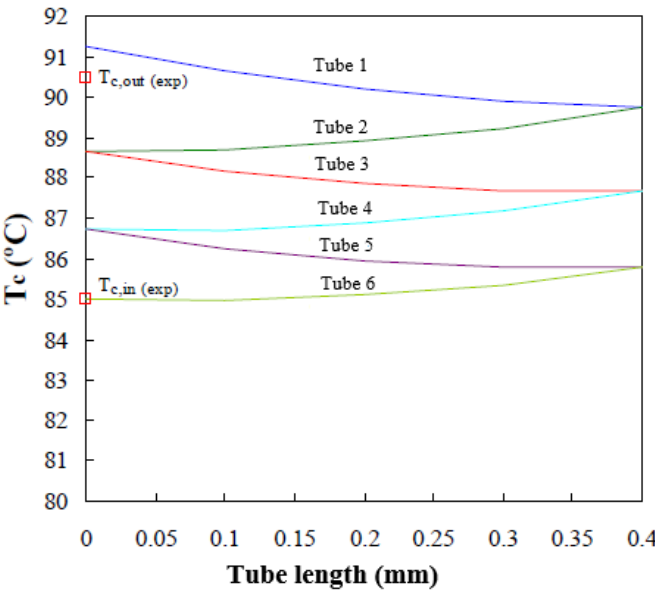
Figure 9. Cooling water temperature profile along the tube